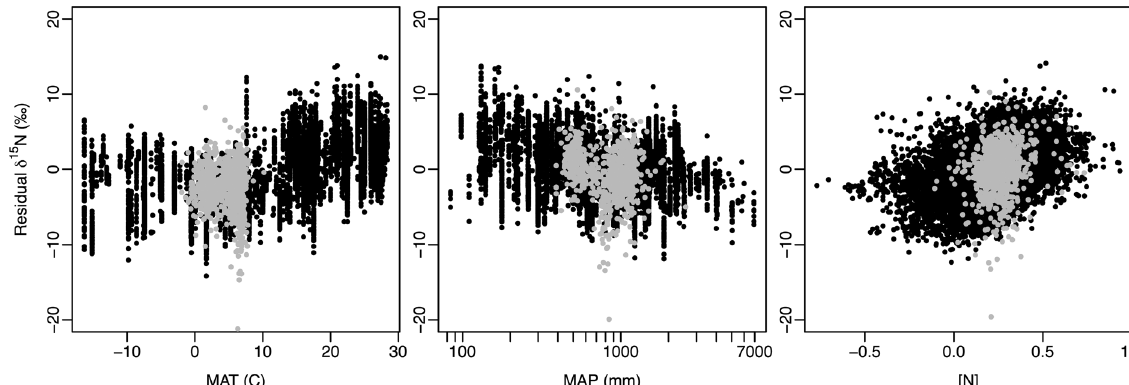
Figure 2. Relationship between residual δ 15 N with mean annual temperature (MAT), mean annual precipitation (log transformed MAP), and nitrogen concentration ([N]). Residual δ 15 N is calculated relative to a model including the two remaining model effects. Globally distributed observations from 1273 species in black (n = 9828); observations of P . balsamifera (n = 755) in grey.